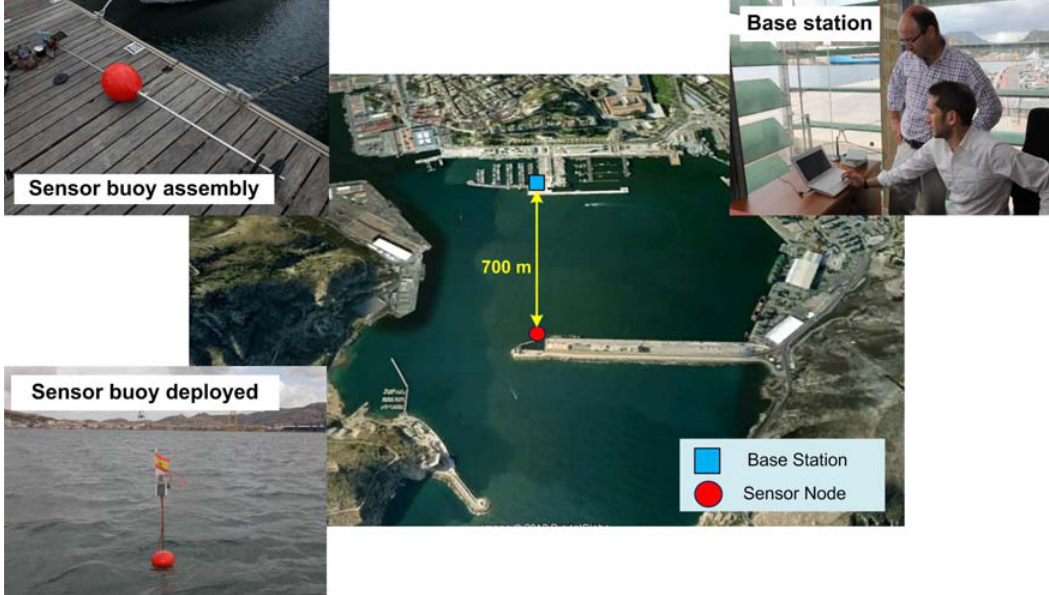
Figure 6. Location and deployment of tests in Cartagena